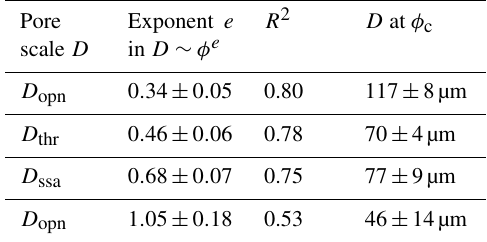
Table 3. Pore scale exponents and